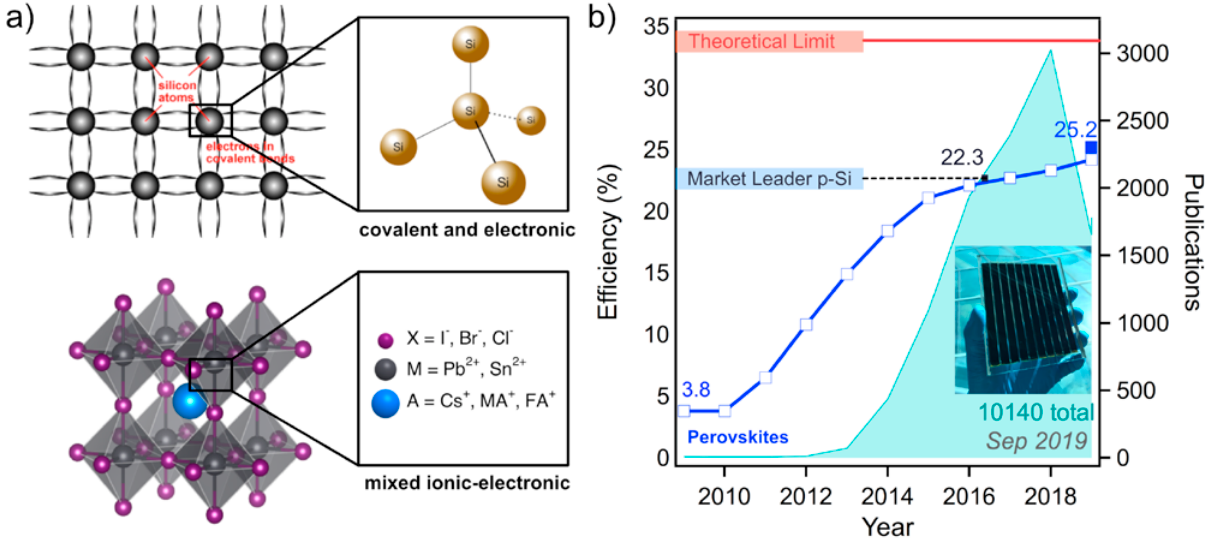
Figure 2. Structural representation of solar cell materials and the evolution of their performance. (a) Schematic representation of the struc- ture of silicon (upper; figure adapted from ref. 24 ) and hybrid perovskites (lower) with the chemical formula AMX 3 . (b) Evolution of the pho- tovoltaic performance of PSCs since 2009 (blue) in comparison to polycrystalline silicon (22.3% efficiency) and the theoretical limit (red), with the corresponding number of publications on hybrid perovskite solar cells (based on the Scopus analysis for the term “perovskite solar cell” on September 23, 2019). In 2019 the efficiency of PSCs has reached 25.2%. 16 A representative photo of a perovskite solar cell is shown in the inset (photo credit to the researchers at NTU Singapore).